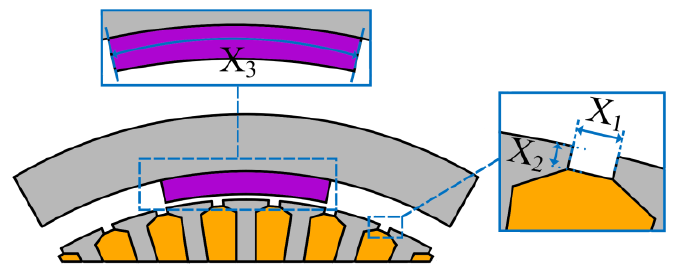
7 of 20 Figure 7. Winding harmonics. 3.3. Variables and Objective Function The objective function of this study is to enhance torque performance of the machine for electric vehicle application. Accordingly, the following development processes are considered to be investigated using 2D Finite Element Analysis (FEA). The initial design parameters are presented in Table 2., and the variables considered for sensitivity analysis of the candidate model are illustrated in Figure 8.  Initial Configurations  Objective Function: minimum torque pulsation, satisfying torque density and Back-EMF: determi- nation through q selection  Constraints: initial design parameters in Table 2.